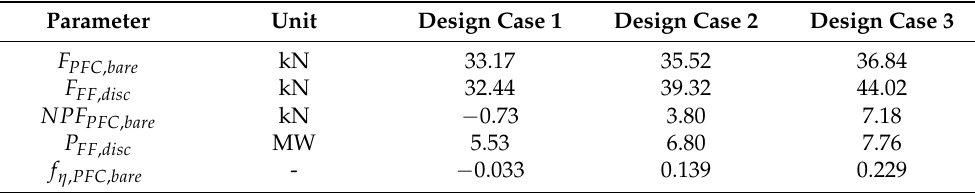
Table 2. Overview of the main aerodynamic performance parameters for three different case studies based on the Rev07 axisymmetric bare PFC design.